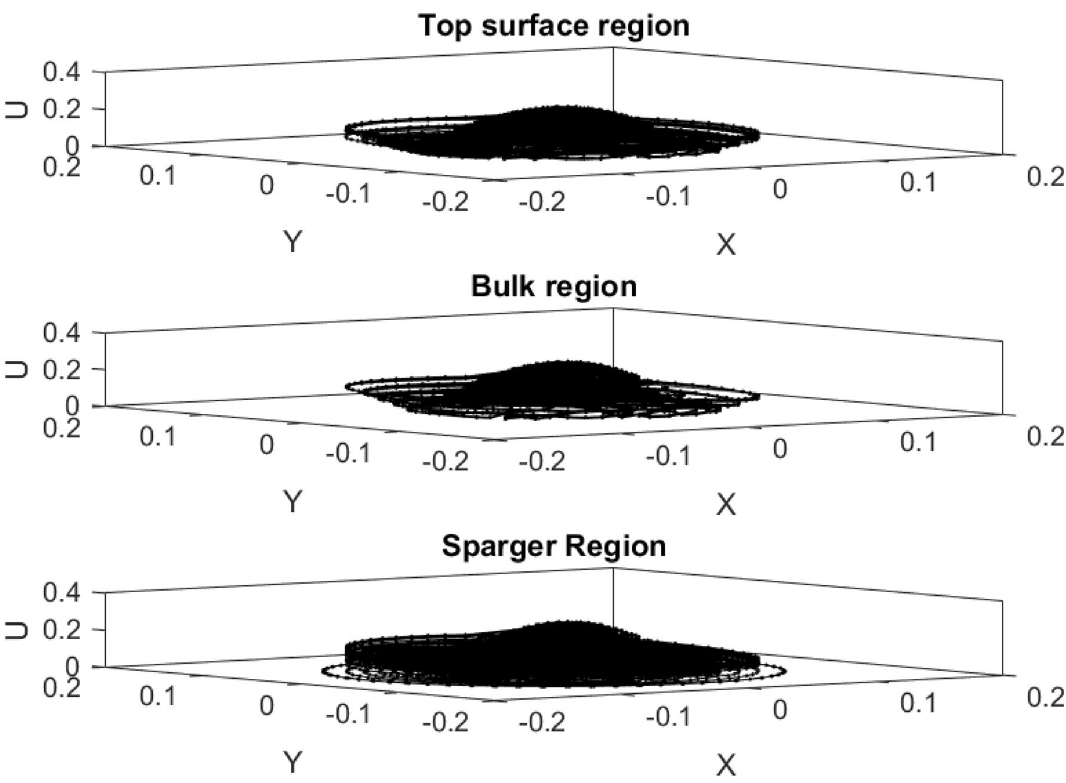
+ U 2 + U 2 ) at X and Y computing points for top surface, U 2 x y z (cid:31)